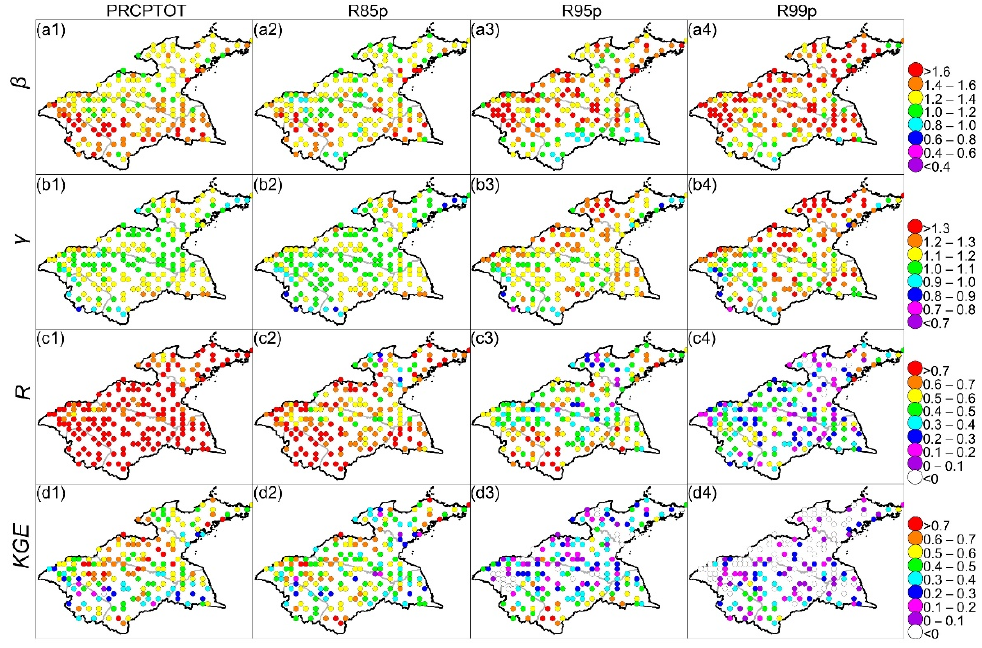
Figure 3. Spatial patterns of different validation metrics for the amount-based indices. At space, the observational PRCPTOT, R85p, R95p, and R99p trends had a similar distribution, i.e., decreased over western and southeastern parts, but increased in other regions, with the HRB trends of 4.17 mm/yr, 3.68mm/yr, 3.13 mm/yr, and 1.69mm/yr, respectively (Figure 4a1–a4). Moreover, the percentage of the grids with positive trends for each index was always ≥ 56%. As shown in Figure 4b1–b4, each of the PERSIANN- CDR amount-based indices corresponded to underestimated trends at most (>50%) grids; for the regional mean, the HRB β < 0.5 suggested that the PERSIANN-CDR seriously underestimated the trends of these amount-based indices, especially for the PRCPTOT with opposite changes (i.e., β = − 0.18) between the observation and the PERSIANN- CDR. Except for PRCPTOT, the spatial variabilities of R85p, R95p, and R99p trends were overestimated with the HRB γ values >1.00. The PERSIANN-CDR showed a moderate performance (spatial R = 0.39) in producing spatial patterns of PRCPTOT trends, but much limited capacity (spatial R s < 0.20) existed for the other three indices. Based on KGE , it is evident that the PERSIANN-CDR had no ability (i.e., KGE s < 0) to present the trends of these amount-based